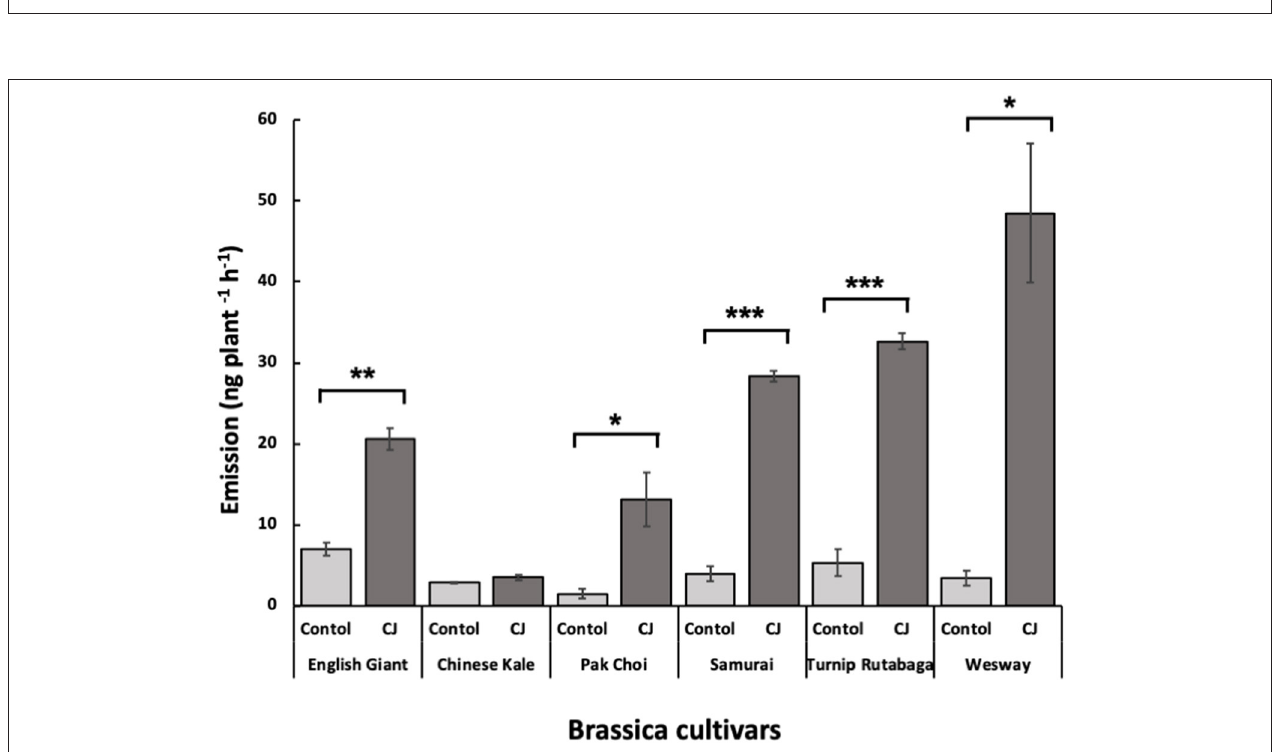
FIGURE 8 | Total amount (mean nanograms plant − 1 h − 1 ± SE) of identified volatile organic compounds (VOCs) emitted from the six brassica cultivars with and without CJ-treatment. Asterisks indicate statistically significant differences: *** < 0.001 and * < 0.05 (paired t -test).